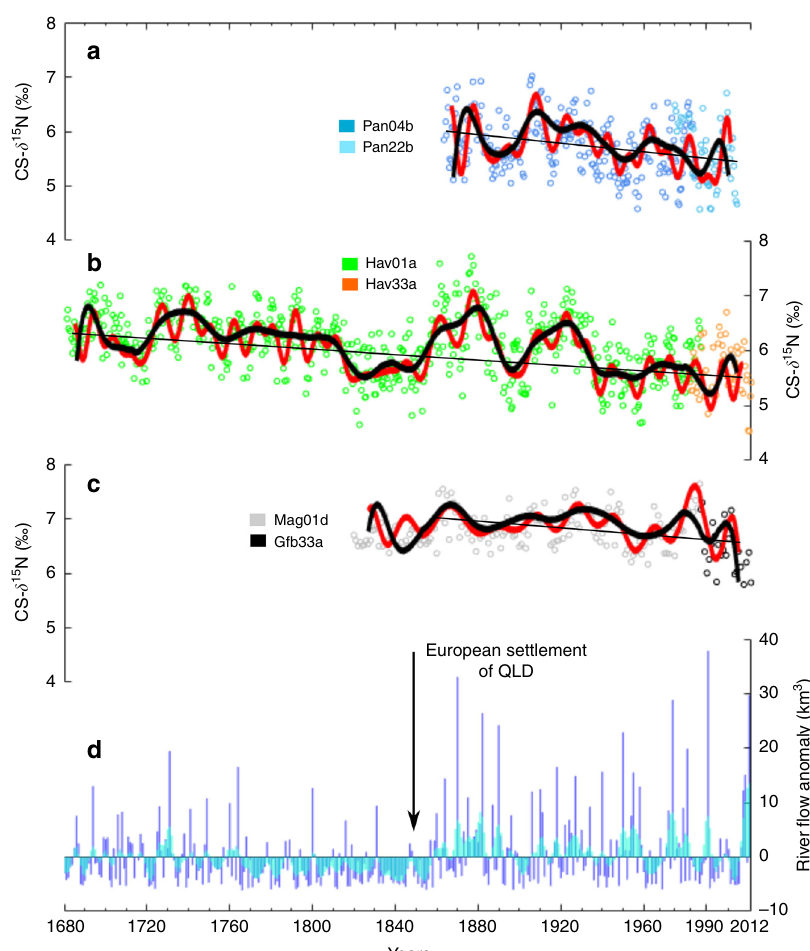
Fig. 2 Coral skeleton CS- δ 15 N and reconstructed Burdekin River fl ow records. a Raw data from the two Pandora Reef cores (Pan04b and Pan22b — open circles) overlain with low-pass- fi ltered CS- δ 15 N (black line = <25 yr frequencies removed) and high-pass- fi ltered CS- δ 15 N (red line = <10 yr frequencies removed). The straight line is the regression for the composite record (slope = 0.004 ‰ yr − 1 ). b Raw data from the two Havannah Reef cores (Hav01a and Hav33a — open circles) overlain with the low and high pass fi ltered CS- δ 15 N (black and red lines, respectively). The straight line is the regression for the composite record (slope = 0.002 ‰ yr − 1 ). c Raw data from the two Magnetic Island cores (Mag01d 46 and Gfb33a — open circles) overlain with the low and high pass fi ltered CS- δ 15 N (black and red lines, respectively). The straight line is the regression for the composite record between 1860 and 2011 (slope = 0.002 ‰ yr − 1 ). d Reconstructed Burdekin River fl ow anomalies 50 , data are annual (October – September) water year values (km 3 ) normalised to the overall mean fl ow between 1680 and 2011. Blue lines are the annual values, and blue shading is the 3-year running